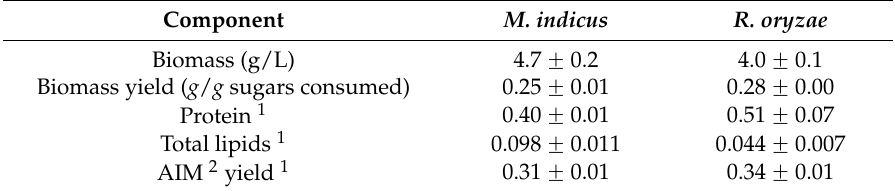
Table 2. Analysis of fungal biomass obtained from cultivation of the fungi on CWFS in airlift bioreactor without any auxiliary nutrients. Data are mean ˘ SD and n =